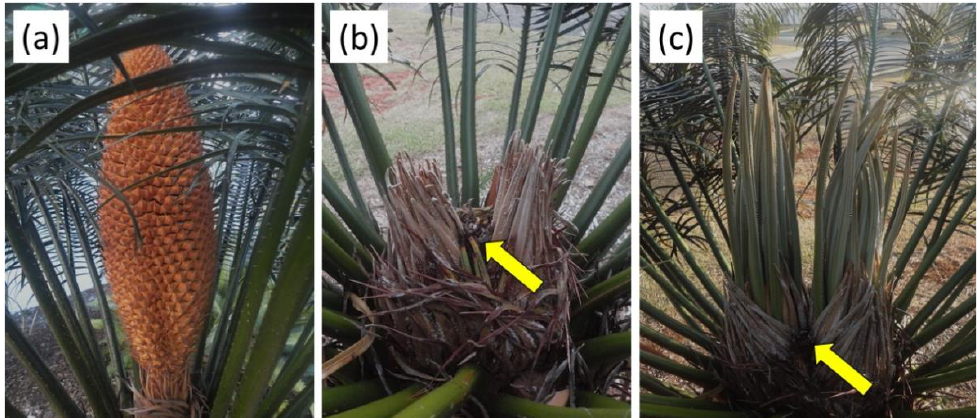
Figure 5. The reproductive behavior of a male Cycas plant. ( a ) July 2019 microstrobilus is determinate and terminates the stem growth; ( b ) the appearance of two adventitious apices becomes apparent five months later; ( c ) resumption of stem growth is apparent seven months after the microstrobilus. Yellow arrows point to the base of the antecedent microstrobilus.